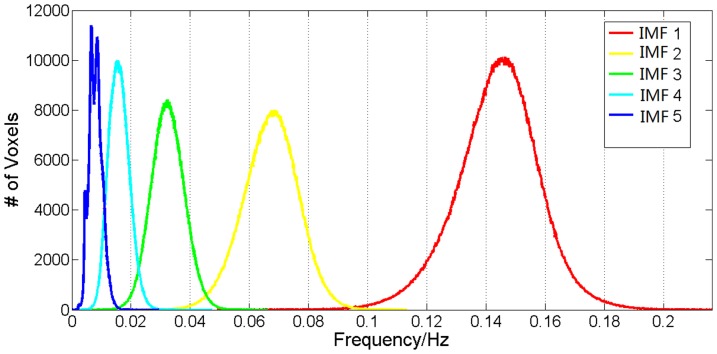
Frequency properties of IMFs.The histograms of HWF of IMF1 to IMF5 (color-coded by red, yellow, green, cyan and blue respectively) were determined from all the voxels in the whole brains across all the 198 subjects. Heights of the histograms represent the number of voxels whose HWF equals that frequency on the horizontal axis.